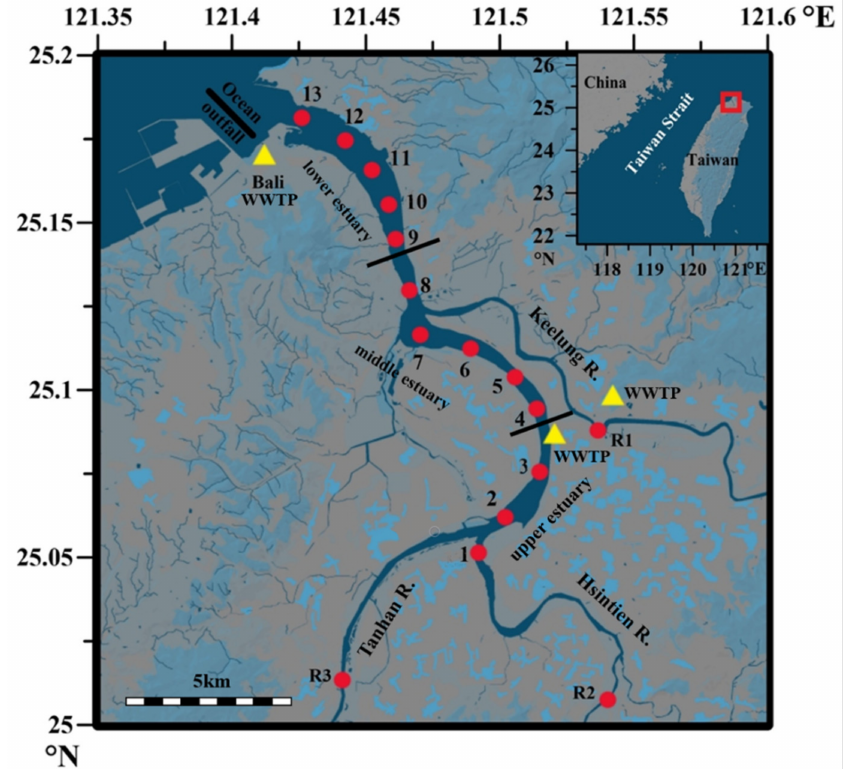
Figure 1. Sampling stations (1–13) along the Danshuei River Estuary in the northern Taiwan. (WWTP: wastewater treatment plant). R1-R3 represents the investigation stations of the water quality carried out by EPA, Taiwan. These three stations are located in the tributaries, namely the Keelung (R1), the Hsintien (R2) and the Tanhan (R3), of the Danshuei River